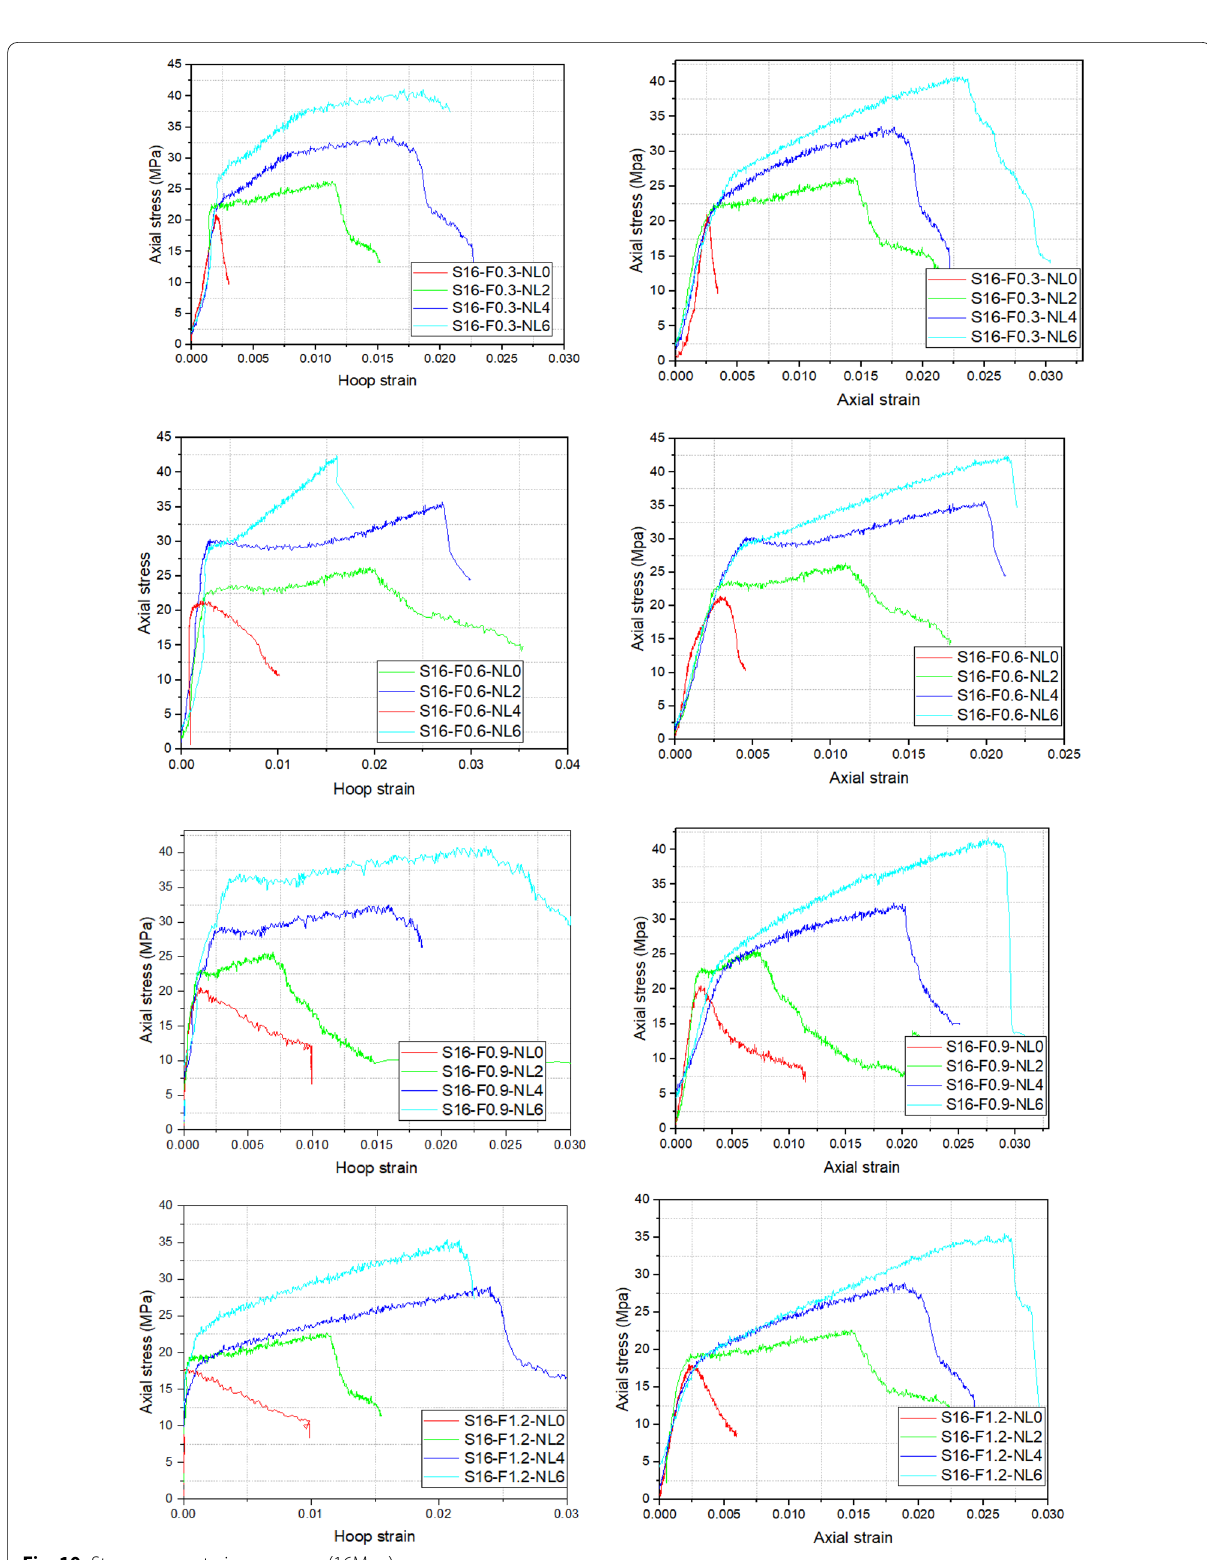
Fig. 10 Stress versus strain responses